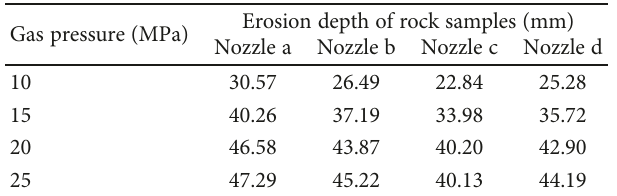
Table 12: Erosion depth of the di ff erent nozzles when gas pressure is di ff